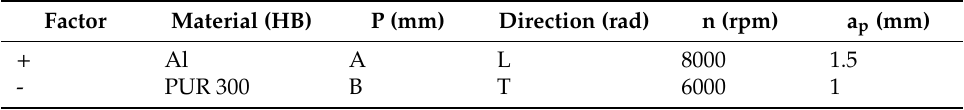
Table 3. ( a ) Tests for Al. ( b ) Tests for PUR 300.